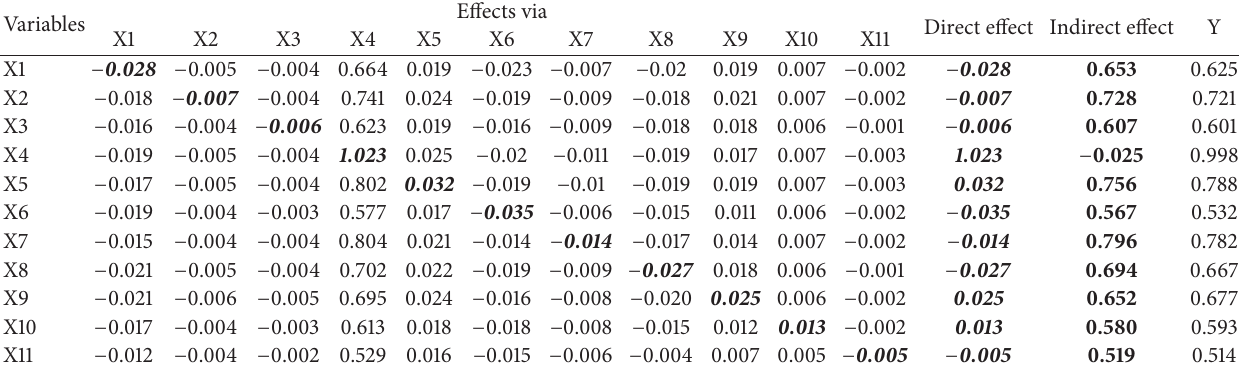
Table 3: Path coefficient (direct and indirect effects) of the measured variables attributed on grain yield variation of wheat in inoculation condition and different water